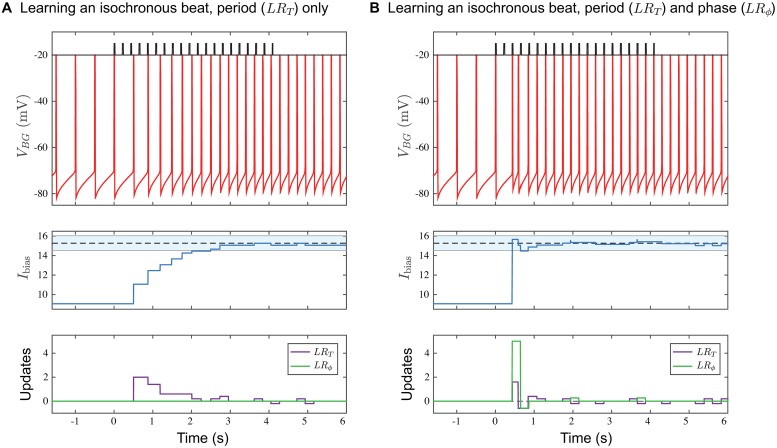
Effect of learning rules.A. Period Matching with LRT. The voltage time course (top) of the BG is shown under three different conditions; i) Endogenously oscillating at 2 Hz with no stimulus and no learning rule from t = −1.5 to 0 s; ii) Learning the 4.65 Hz isochronous period in the presence of the stimulus from t = 0 to 4.2 s; iii) Performing synchronization continuation once the stimulus is removed at t = 4.2 s. Ibias changes on a cycle-by-cycle basis (middle panel). Around t = 2.25 s, Ibias enters the shaded blue regime (14.54, 16.03) that represents the one gamma cycle accuracy range from the 15.27 value that produces exactly 4.65 Hz. After t = 2.75 s, Ibias lies very close to the correct value. Updates to Ibias rely solely on LRT, the period learning rule (lower panel). B. Period and phase matching with both LRT and LRϕ. Time courses are the counterparts of those in Panel A. Now the convergence to the correct frequency and phase occurs very quickly by about t = 1.2 s. Note the early large change in Ibias due to LRϕ. In both panels after t = 4 s, there are still changes to Ibias as there are minor adjustments to Ibias though the frequency of the BG stays within the equivalent of one gamma cycle accuracy of 4.65 Hz (IBIBG = 215±27 ms). Note that once the stimulus is switched off, only LRT continues to update Ibias. Here, and in Figs 5–8, we used the INaP model and set δT = 0.2, δϕ = 2.5.